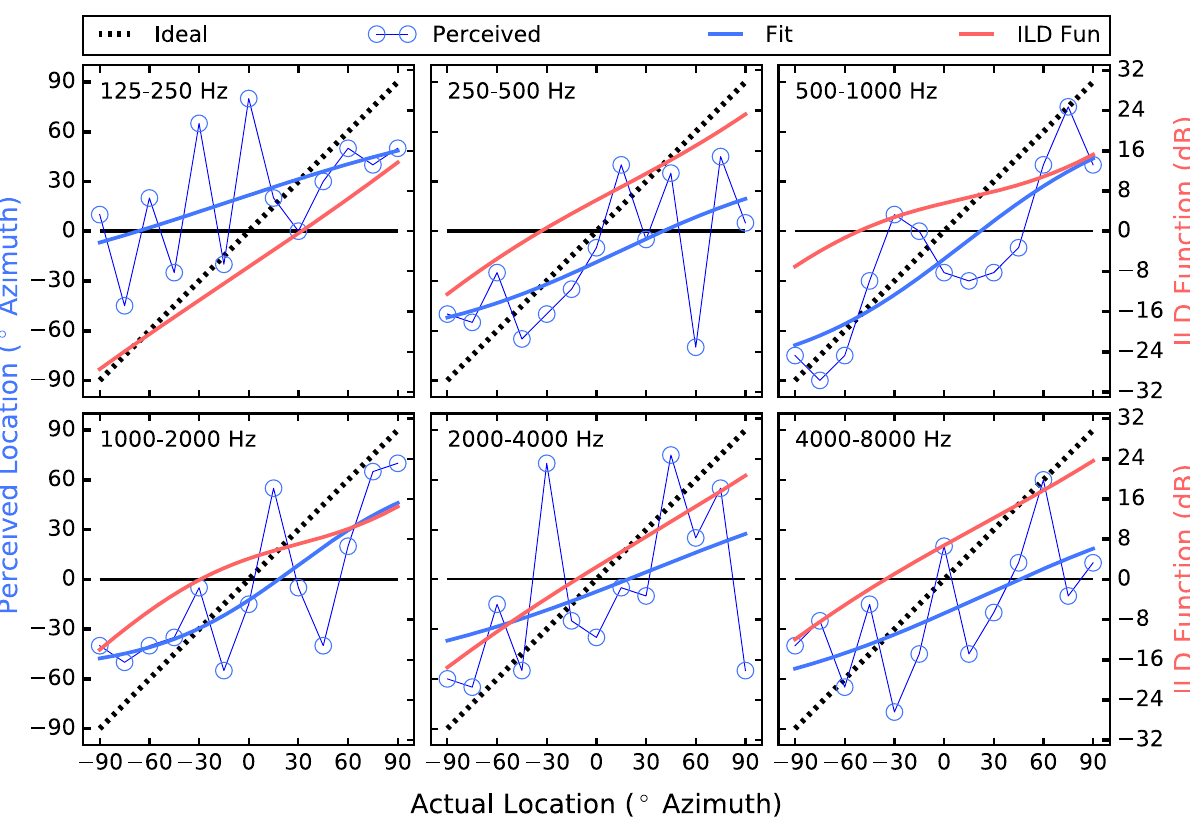
Fig 3. Corrective ILD generation data for participant 2287. The layout is identical to that of Fig